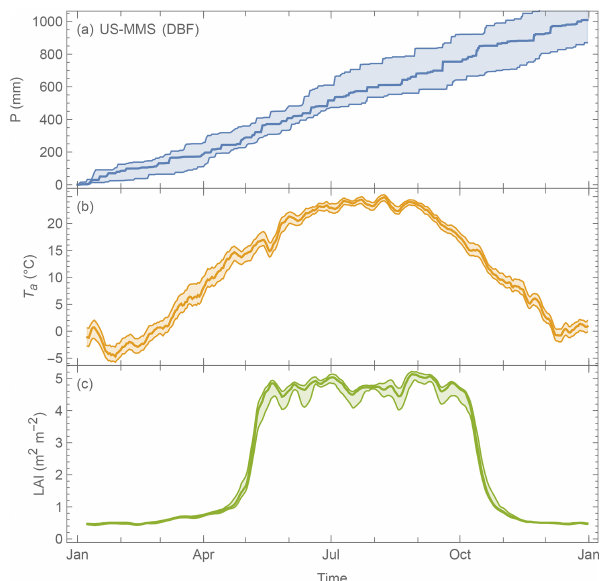
Figure D1. Median (line) and interquartile range (shading) daily variation at US-MMS a DBF site during the period 2002–2015 of (a) precipitation (cumulative), (b) air temperature (7d moving av- erage) and (c) LAI (7d moving average).